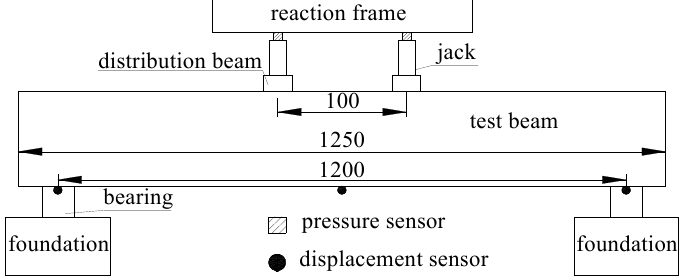
Figure 6. Schematic view of four-point bending test (unit: cm).